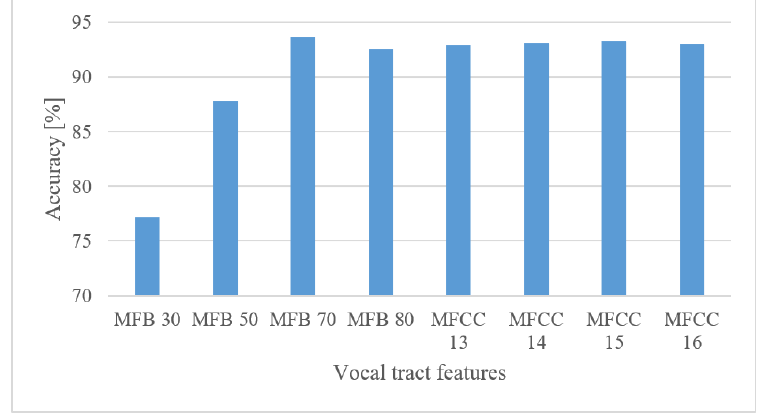
Figure 13. Accuracies for 30, 50, 70, and 80 Mel FBs, and 13, 14, 15, and 16 MFCCs for a frequency range of 0–8 kHz.